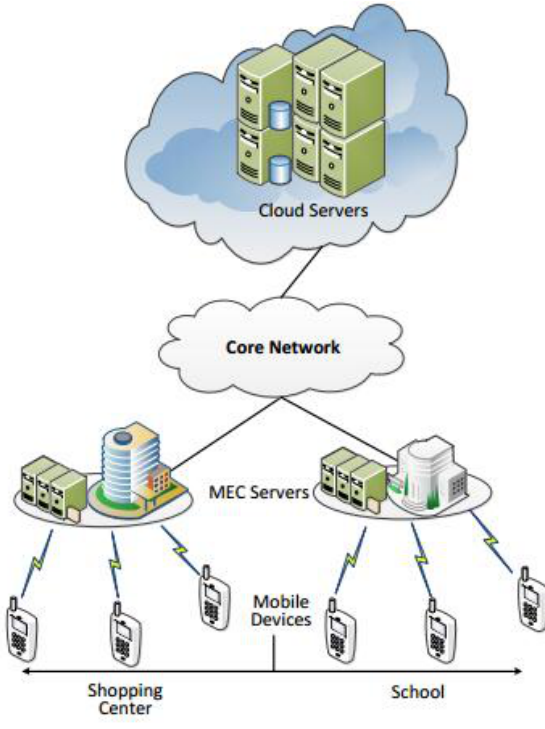
Figure 1. Mobile Edge Computing